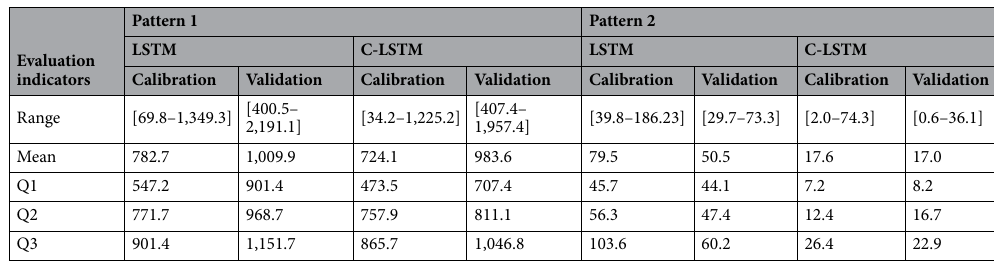
Table 4. BIAS evaluation for the study catchment (Q 1 , the lower quartile; Q 2 , the median; and Q 3 , the higher quartile).